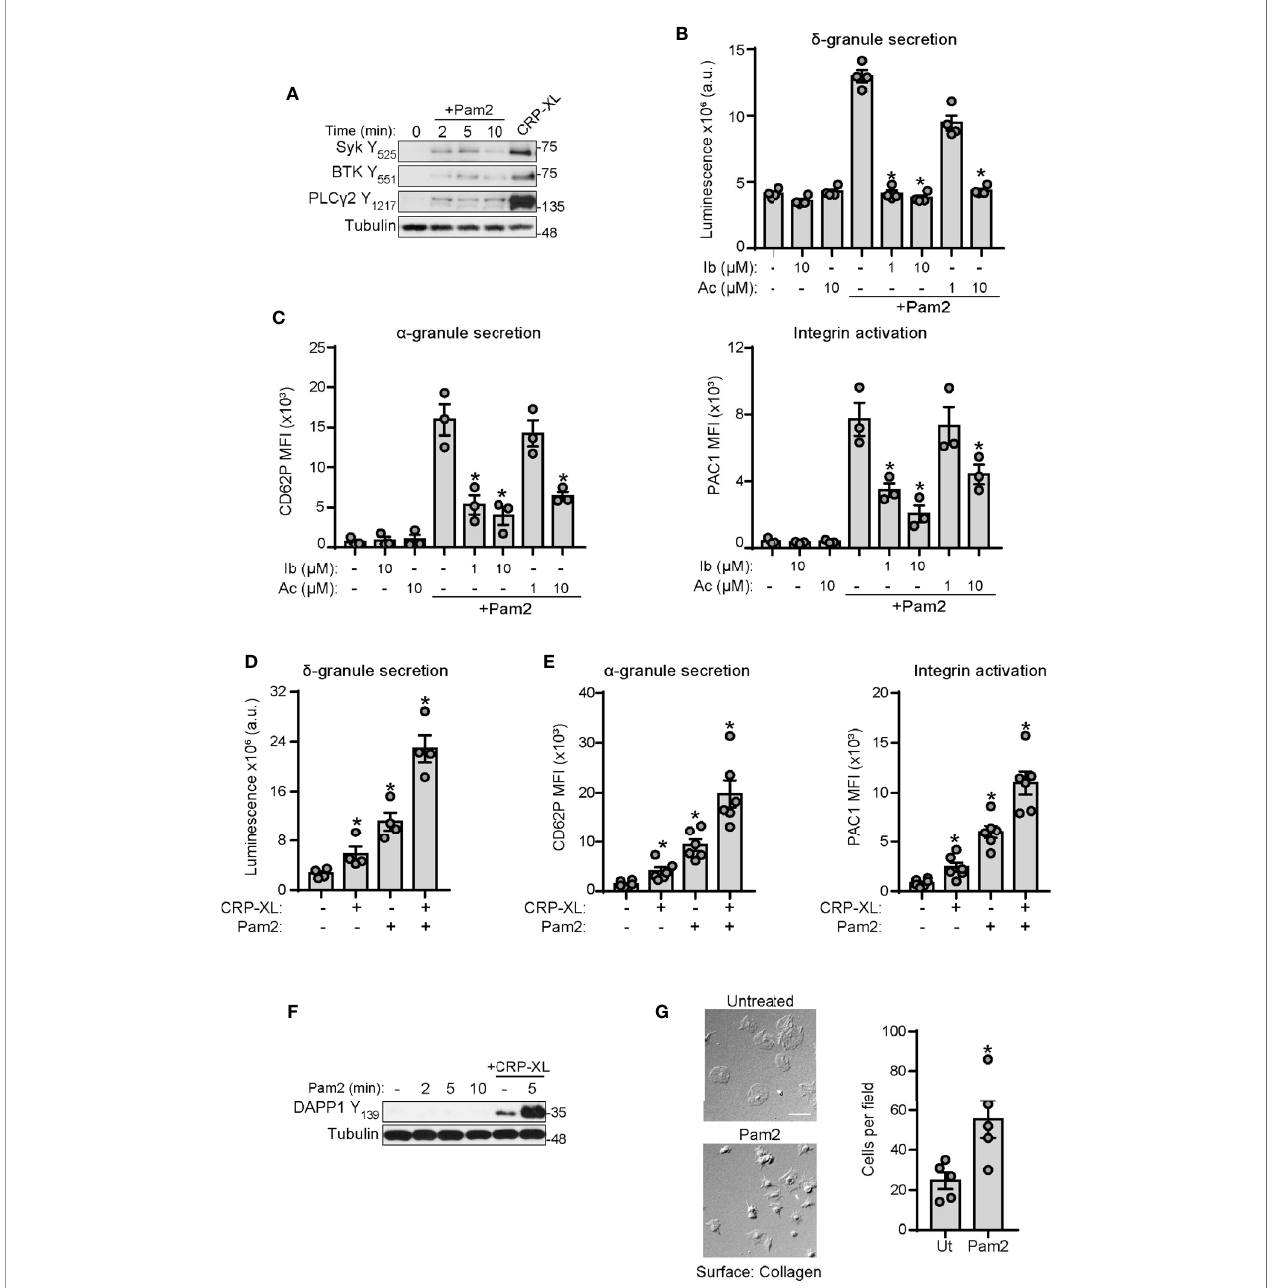
FIGURE 4 | GPVI and TLR2 share common signaling nodes and cooperate to potentiate platelet activation. (A) Replicate preparations of washed human platelets (1x10 9 ml) were activated with Pam2CSK4 (10 µg/ml) or CRP-XL (2 µg/ml; 5 min) and cell lysates analyzed by immunoblot for the indicated antibodies; n=3 independent experiments. (B, D) Platelets (2×10 8 /ml) were incubated with a luciferin luciferase reagent to measure ATP release and dense granule secretion. Data are expressed as raw mean luminescence (a.u.); n=4 experiments. (C, E) Platelets (5×10 7 /ml) were pre-treated and activated as above in the presence of fl uorophore-conjugated antibodies against P-selectin (CD62P-APC) or the activated conformation of human integrin a IIb b 3 (PAC1-FITC) and subsequent analysis by fl ow cytometry; n=3-6 experiments. Data are presented as total mean fl uorescence intensity (MFI). (F) Platelet lysates were prepared as in A and analyzed by Western Blot for DAPP1 activation; representative of n=3 experiments. (G) Cover glass was coated with soluble collagen (50 m g/ml), blocked with BSA, and incubated with replicate samples of washed human platelets (2x10 7 /ml) untreated or stimulated with Pam2CSK4. After 45 min (37°C), cover glass was washed with PBS and adherent platelets were imaged with DIC microscopy; n=5 experiments. Pam2CSK4 was used at 10 µg/ml (A – C, F, G) or 5 µg/ml (D, E) . CRP-XL was used at 2 µg/ml. Scale bar indicates 10 µm. * indicates statistical signi fi cance (p<0.05) compared to Pam2CSK4 (B, C) or to untreated (D – G) . Error bars indicate standard error of the mean